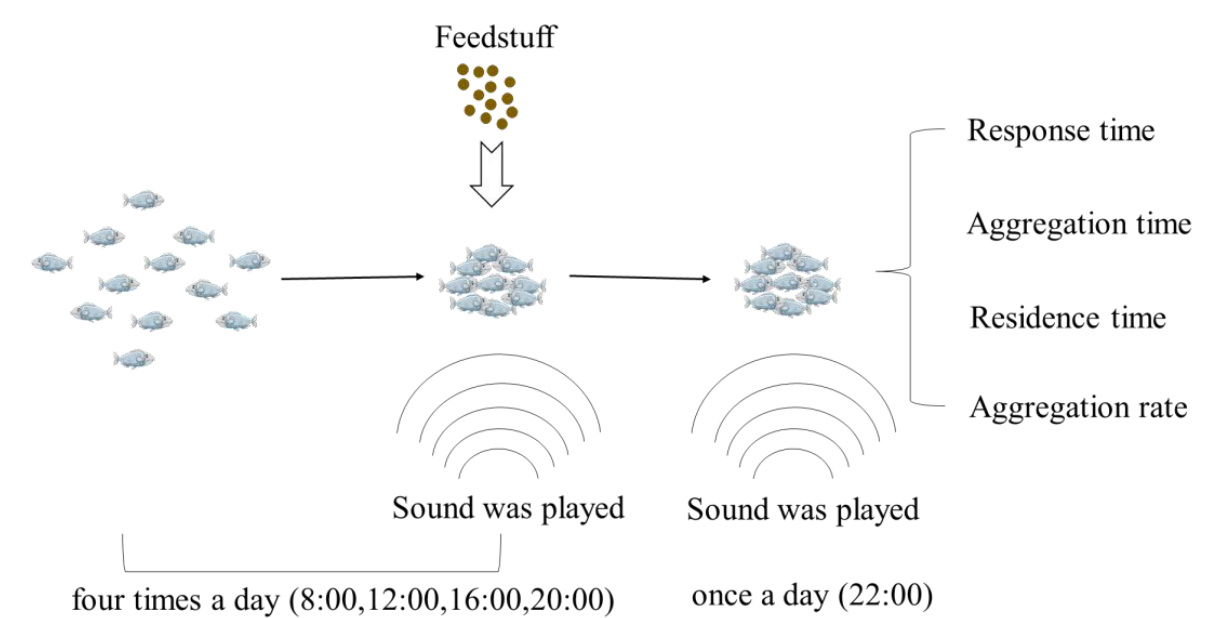
Figure 5. Schematic diagram of the acoustic conditioning taming method in laboratory.